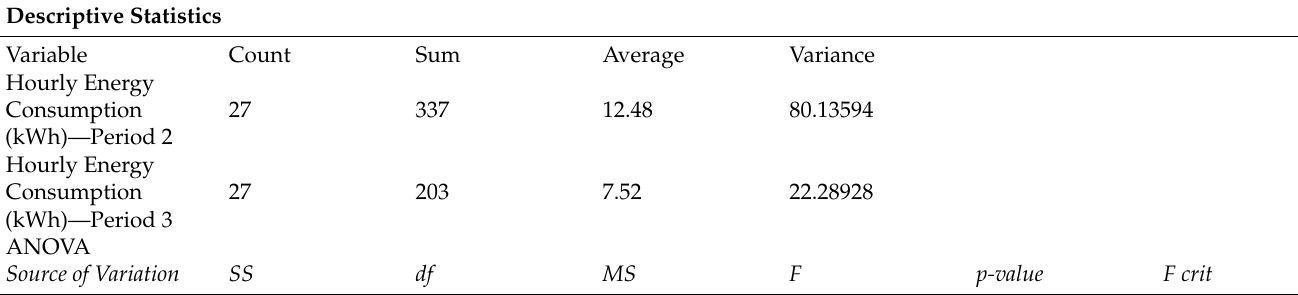
Table A4. Descriptive Statistics of Cooling Energy Consumption and ANOVA Test Statistics (Period 2 vs. Period